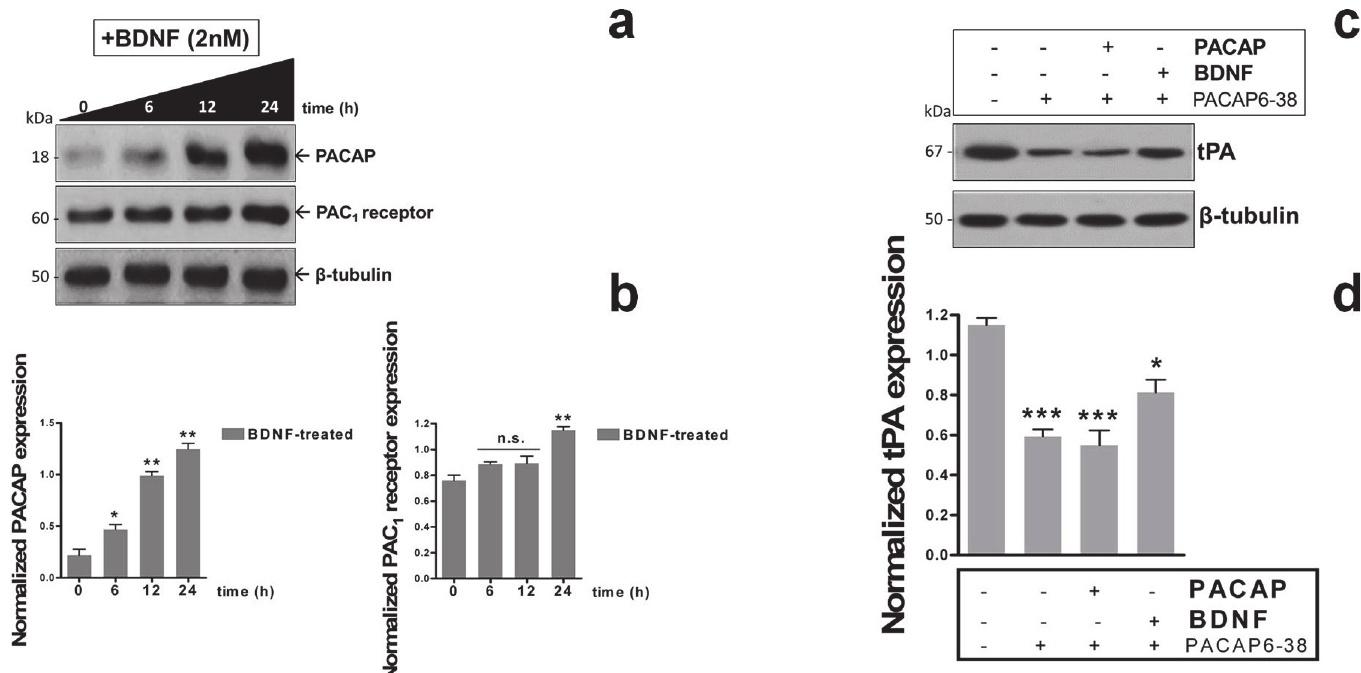
Fig. 5. BDNF boosts endogenous PACAP/PAC 1 receptor signaling to induce tPA expression in RT4-D6P2T cells. Western blots and related quantifications ( a and b ) showing the effect of 2x10 − 9 M BDNF treatment on PACAP peptide and PAC 1 receptor expression at different exposure times (0, 6, 12 and 24h). For experimental procedures please refer to the appropriate section in MATERIALS AND METHODS. Results in ( b ) are the mean ± SEM of normalized values obtained from at least three separate experiments. β -tubulin was used as the loading control. * p < 0.05 or ** p < 0.01 Vs Control ; ANOVA followed by Tukey post-hoc test. Inhibitory effects of the non-specific PAC 1 /VPAC type receptor antagonist PACAP6-38 (10 μ M) on tPA protein expression were determined by Western blots ( c ). Cells were either left untreated (control) or pretreated with PACAP6-38 in the absence or presence of PACAP or BDNF and tPA expression was evaluated. Quantification of bands was performed by normalizing tPA band density to that of β -tubulin, which was used as loading control. Each experiment was reproduced three times with similar results. Depicted in the bar graph are the average ratios ± SEM. * p < 0.05 or *** p < 0.001 Vs Control ; ANOVA followed by Tukey post-hoc